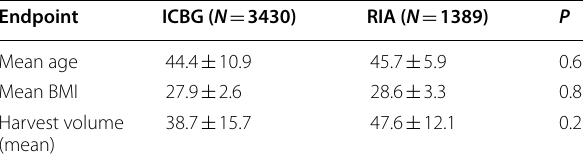
Table 3 Patient baseline demographics of the included studies